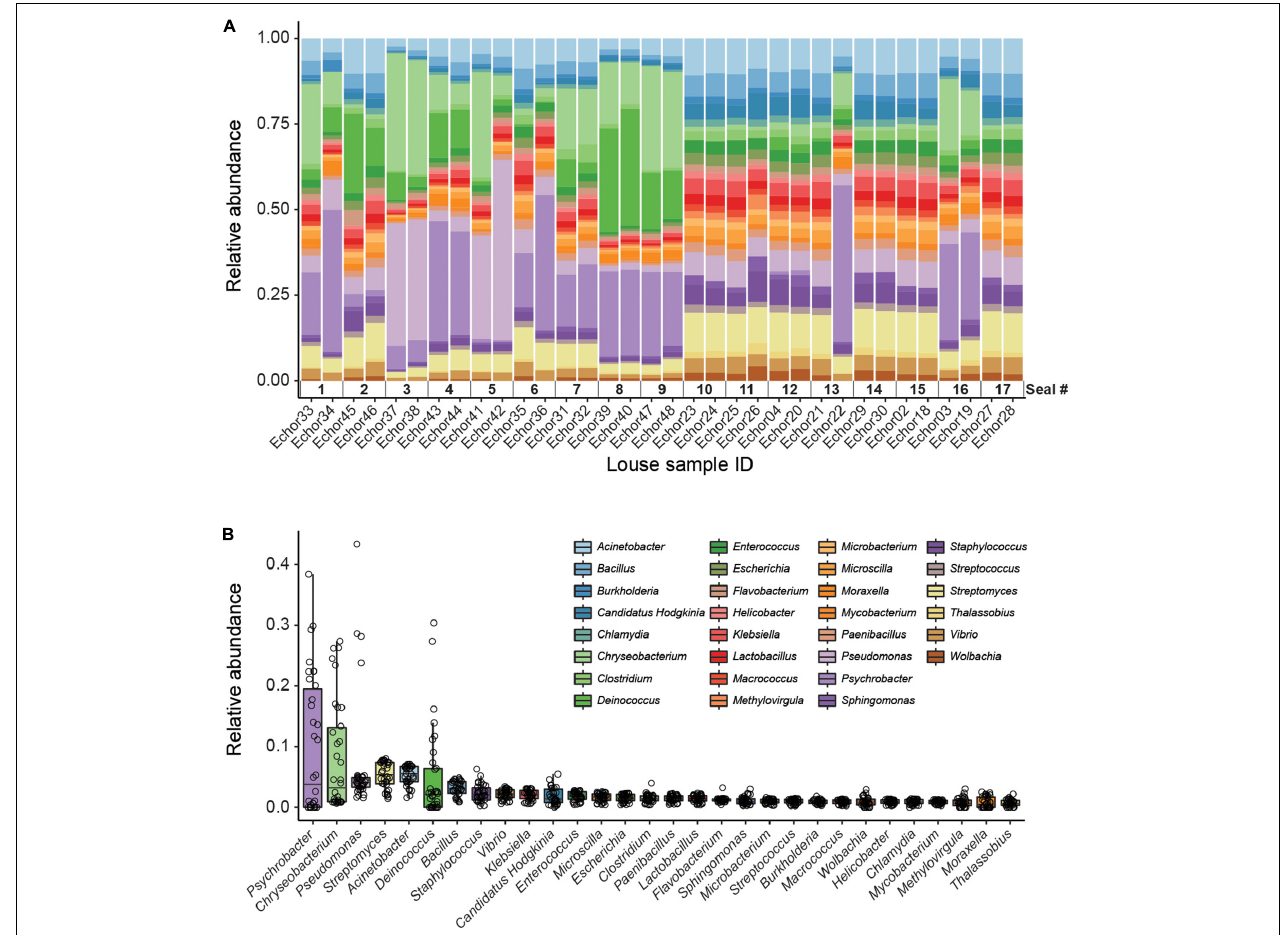
FIGURE 2 | Kaiju data (genus level). (A) Stacked bar plot showing bacterial relative abundances in each seal louse sample. Note that samples are sorted according to host individual (i.e., samples from the same host are next to each other). (B) Boxplot summarizing the relative abundance of each taxon across all louse samples. Individual points (horizontally jittered) depict the relative abundance of each taxon in each